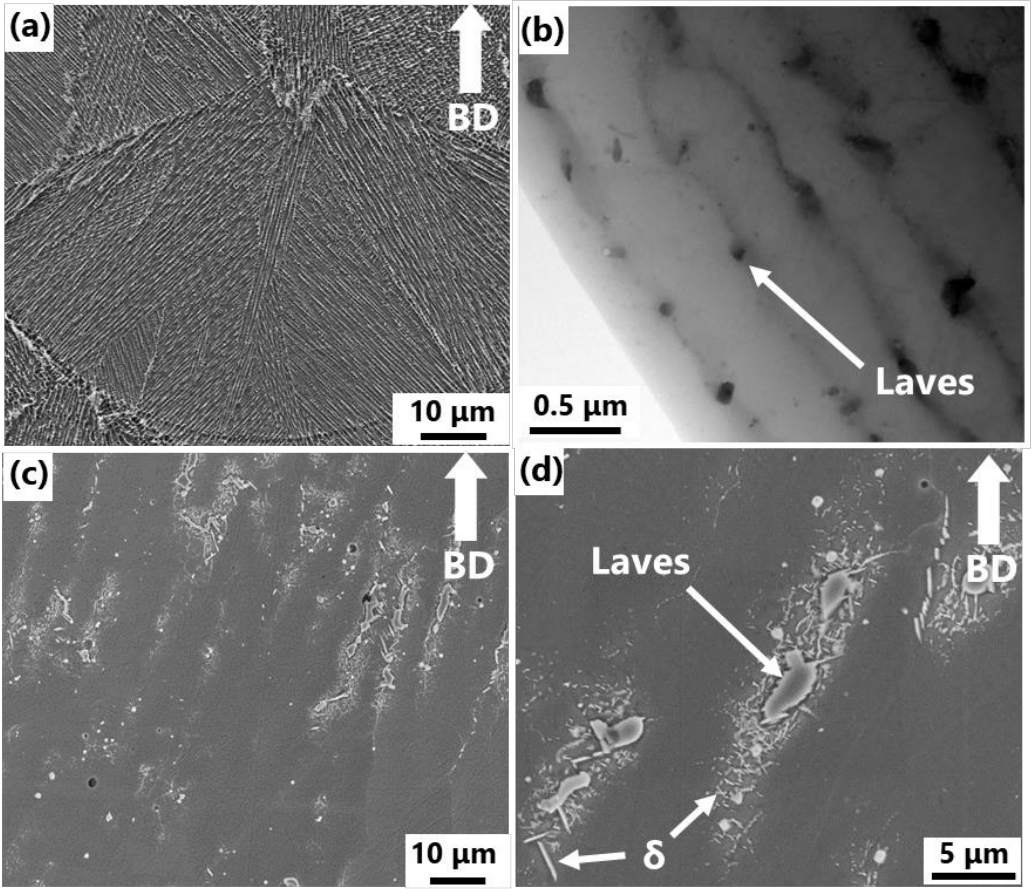
Figure 2. Microstructure of the as-built specimens with higher magnification: ( a,b ) Ar-SLM [11] and ( c,d ) V-SLM. © 2020 Scripta Materialia